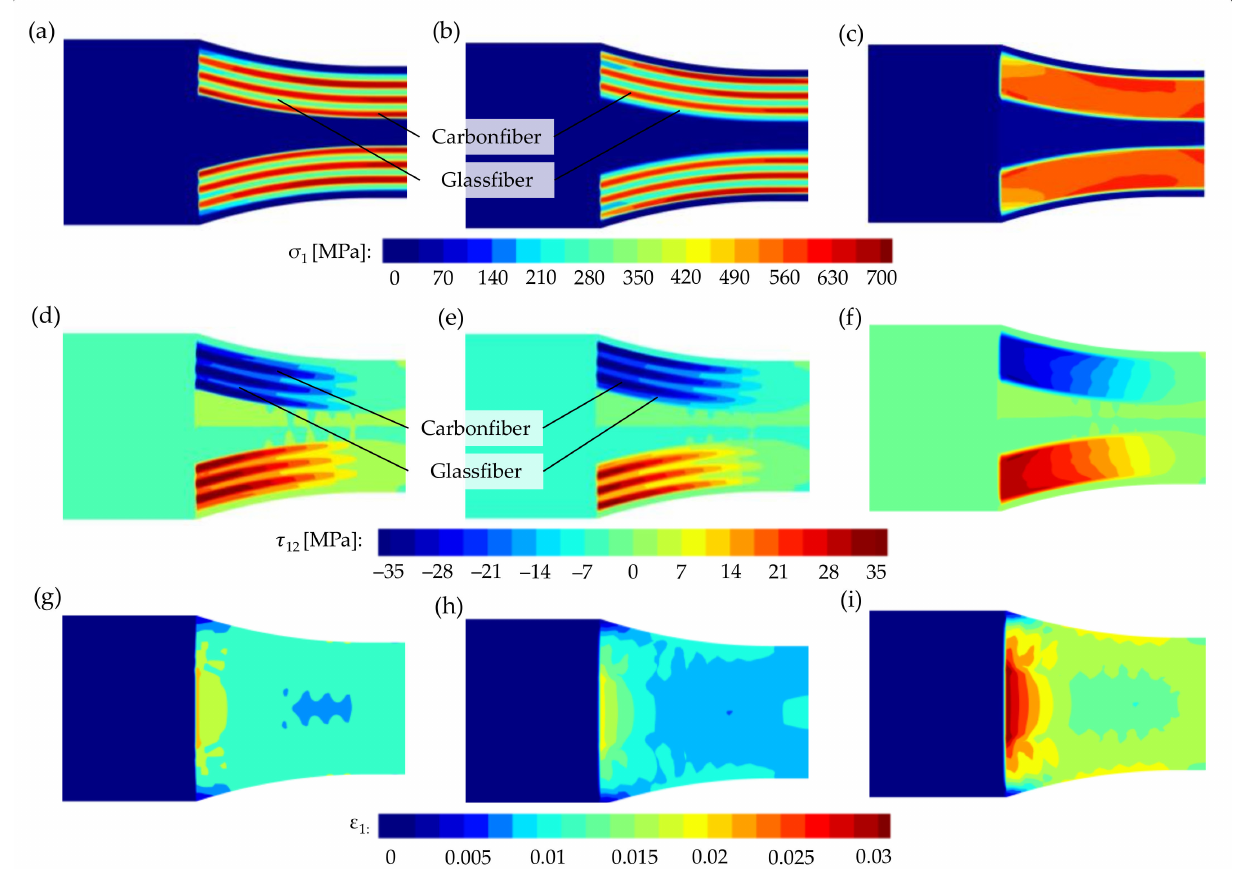
Figure 12. Normal stresses in the longitudinal direction σ 1 : ( a , b ) hybrid specimens with different fiber orientations, ( c ) carbon fiber-reinforced specimen; shear stresses τ 12 : ( d , e ) hybrid specimen with different fiber orientations, ( f ) carbon fiber-reinforced specimen; strains in longitudinal direction ε 1 : ( g ) hybrid specimen, ( h ) carbon fiber-reinforced specimen, and ( i ) glass fiber-reinforced